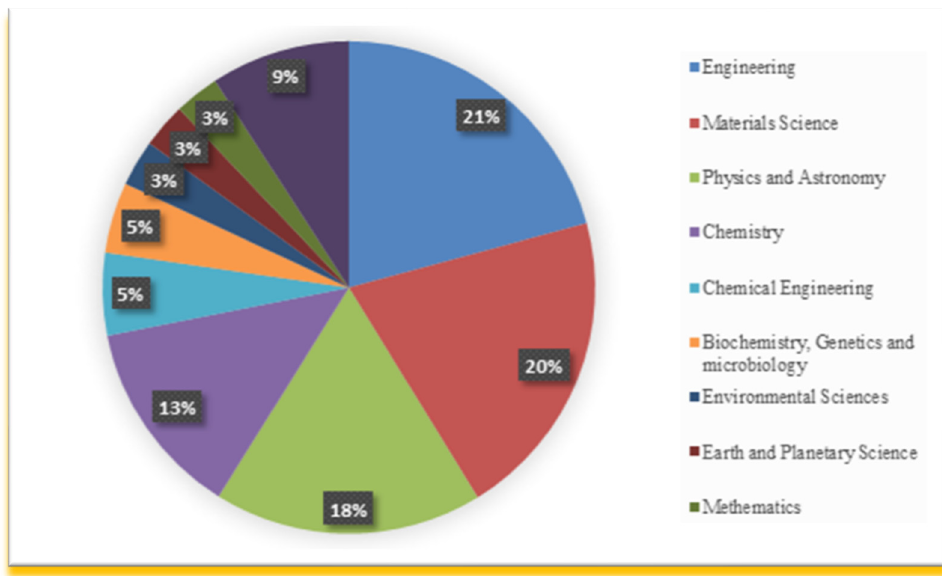
Figure 2. The Publications of nanofluids with respect to different fields of research (source: Scopus.com).